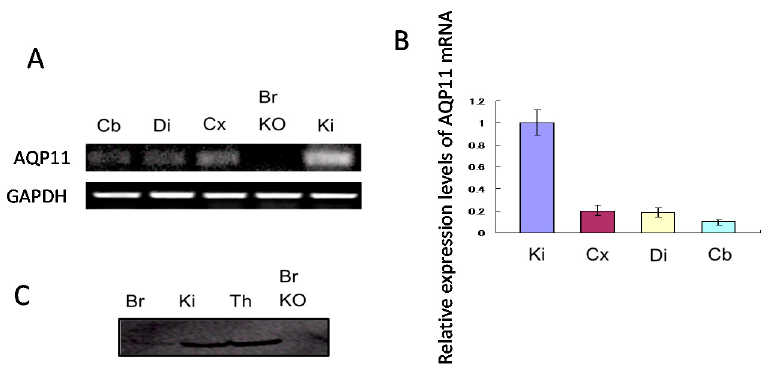
Figure 1. Expression levels of Aquaporin-11 (AQP11) in the brain ( A ) Reverse transcription (RT)-PCR for AQP11 messenger ribonucleic acid (mRNA) in wild type P28 mouse brain and kidney of AQP11-deficient mouse brain; ( B ) Relative abundance of brain AQP11 mRNA in wild-type mouse was compared with that of the kidney. All signals were normalized to the glyceraldehyde-3-phosphate dehydrogenase (GAPDH) mRNA signal. Each bar represents mean ± SD of three experiments; ( C ) Immunoblotting for AQP11 of P28 in the brain, thymus, and kidney of wild type mice and in the brain of AQP11-deficient mice. Cb, cerebellum; Cx, cerebral cortex; Di, diencephalon; Ki, kidney; Th, thymus; Br KO, the whole brain of AQP11-deficient mice.